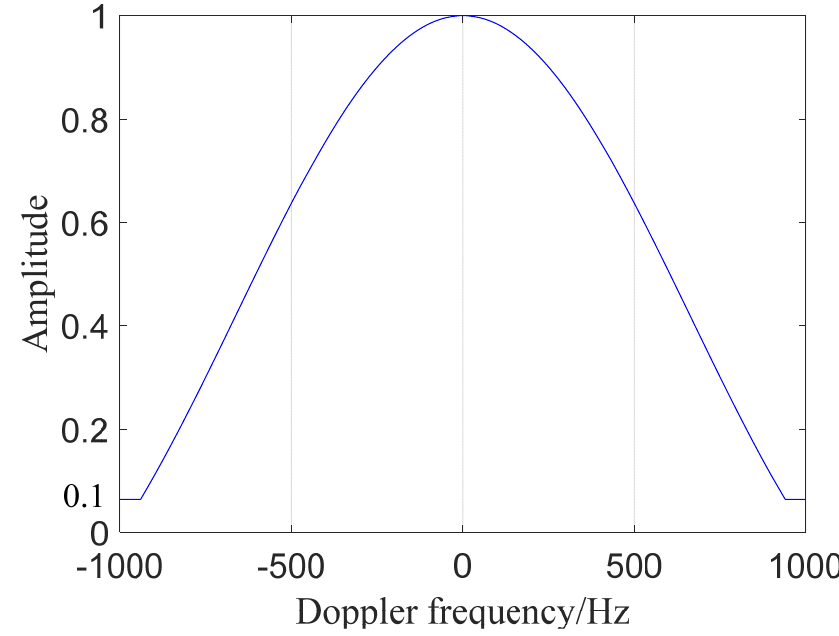
Figure 2. Target peak curves with the Doppler channel in the detection of BDS signals.